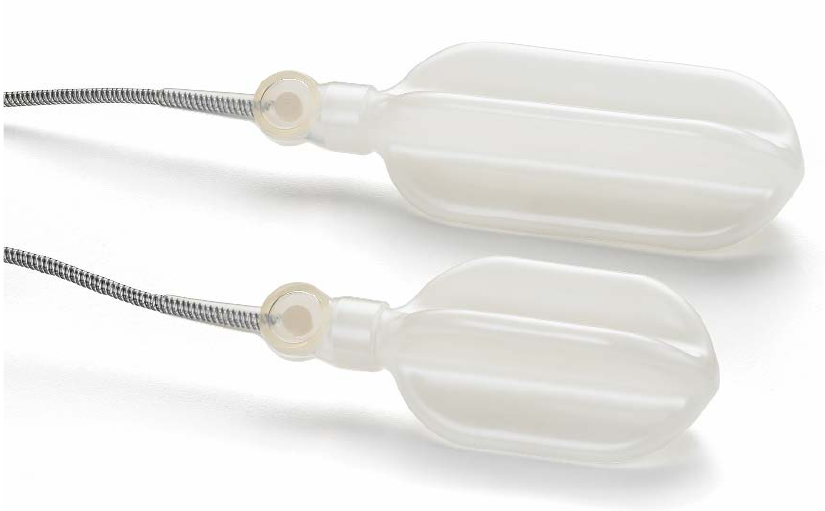
Figure 2. Coloplast cloverleaf reservoir with the lock-out valve is available in 75 and 125 mL sizes. Courtesy of Coloplast, www.us.coloplast.com (accessed on 16 November 2022).